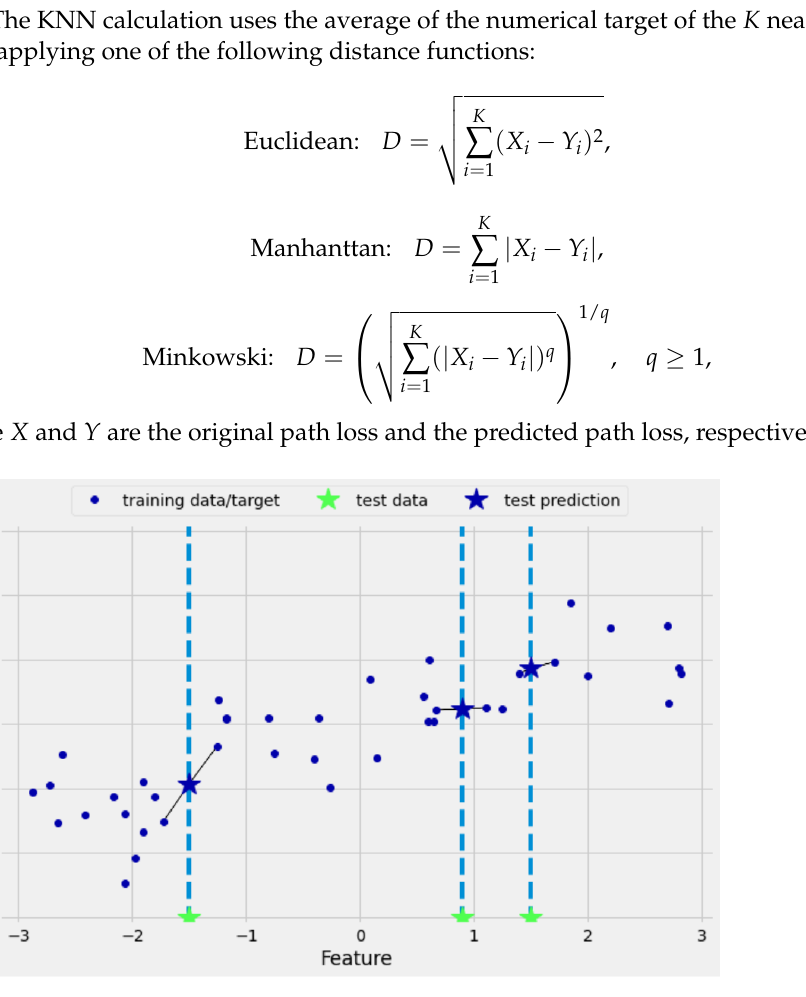
Figure 3. The KNN regression model with K =